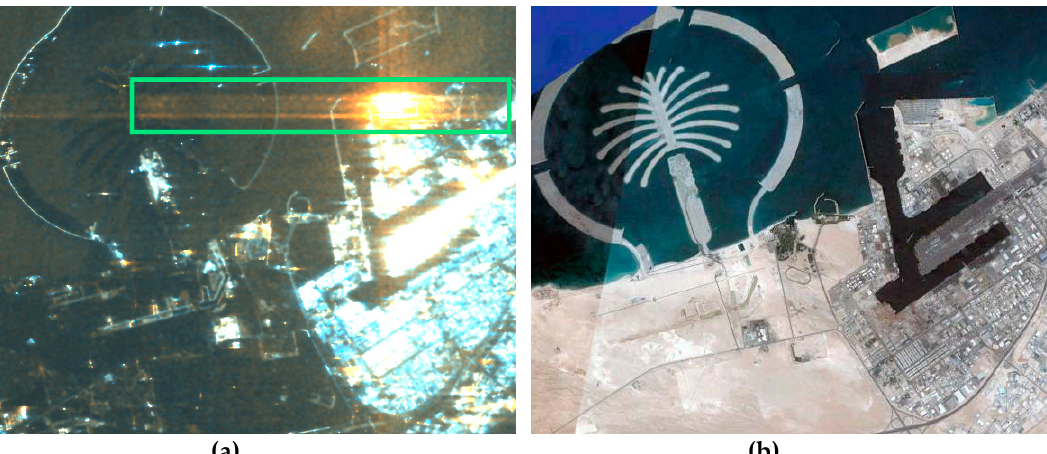
Figure 19. Polarimetric decomposition mistake caused by ADC saturation. The containers on the top lead to a larger area with orange than the truth. ( a ) Dual-polarized image from ALOS-1 at Dubai. | HH × HH ∗ | (Red), | HH × HV ∗ | (Green), | HV × HV ∗ | (Blue). ( b ) Optical image. HH stands for horizontal-horizontal polarization. HV stands for horizontal-vertical polarization.